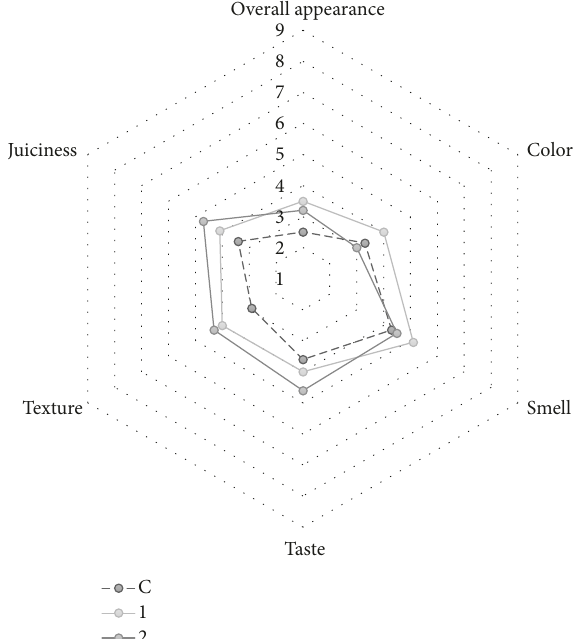
Figure 1: Sensory evaluation of meat